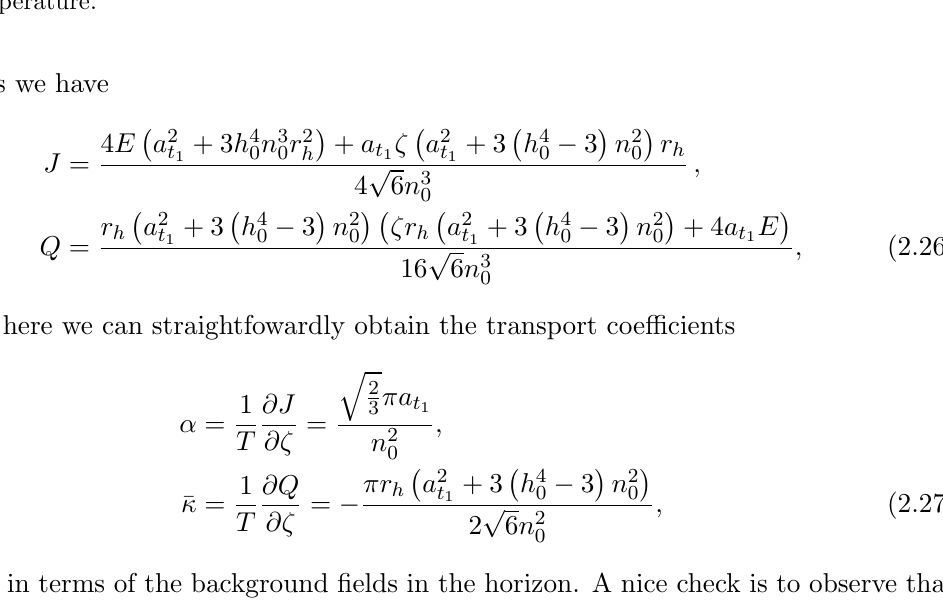
Figure 3 . Left: thermal conductivities (cid:22) (cid:20) (Blue) and (cid:20) (Purple) and the di(cid:11)erence between the two of them (cid:11) 2 T=(cid:27) (Yellow) as a function of the reduced temperature. Right: Wiedemann-Franz ratios (cid:22) L (Blue) and L (Purple) and the di(cid:11)erence between these two (cid:11) 2 =(cid:27) 2 (Yellow) as a function of the